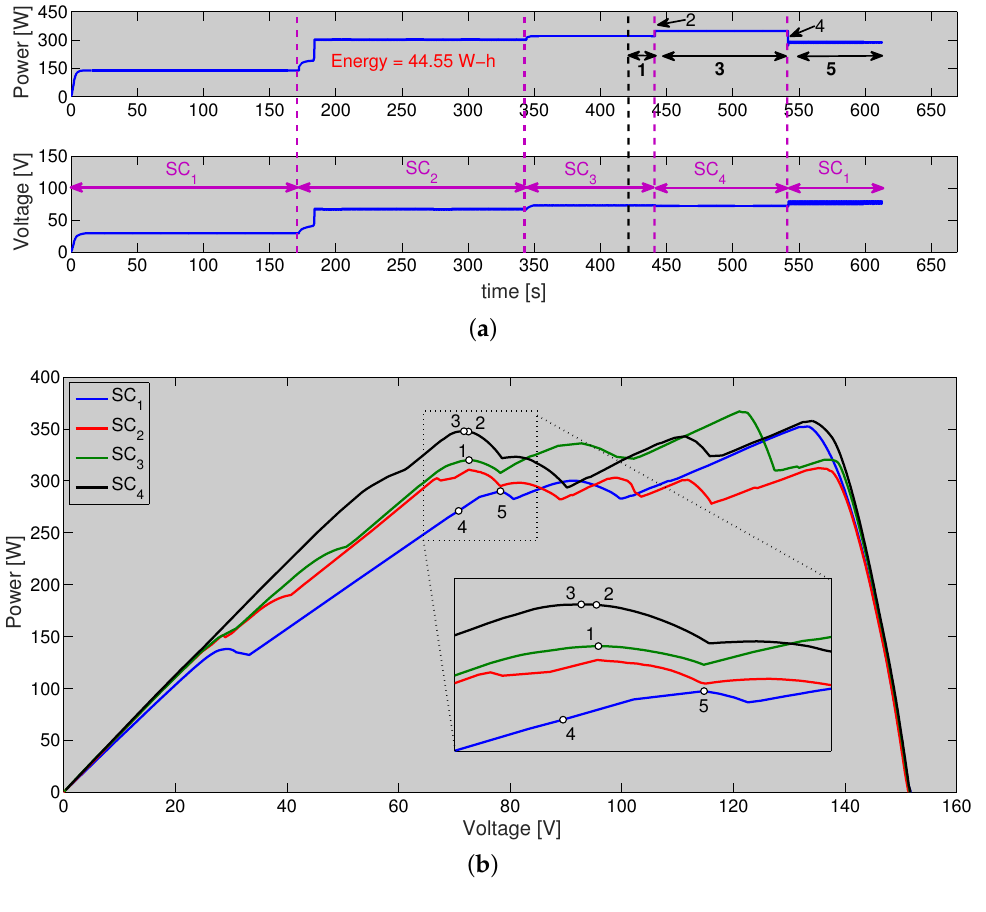
Figure 13. Behavior of the PV array with fixed configuration. ( a ) Dynamic behavior of PV array power and voltage; ( b ) Operating points in the P-V